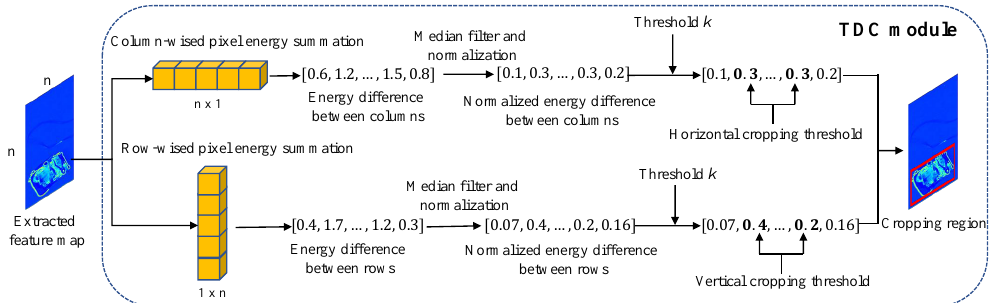
Figure 4. The proposed X-ray image detection pipeline with the TDC module for task-driven cropping. The network backbone for the feature extraction is the same in the detection network. In this work, we use RFB-Net [34] for the detection task, while TDC could also be used for other single-stage detection networks.